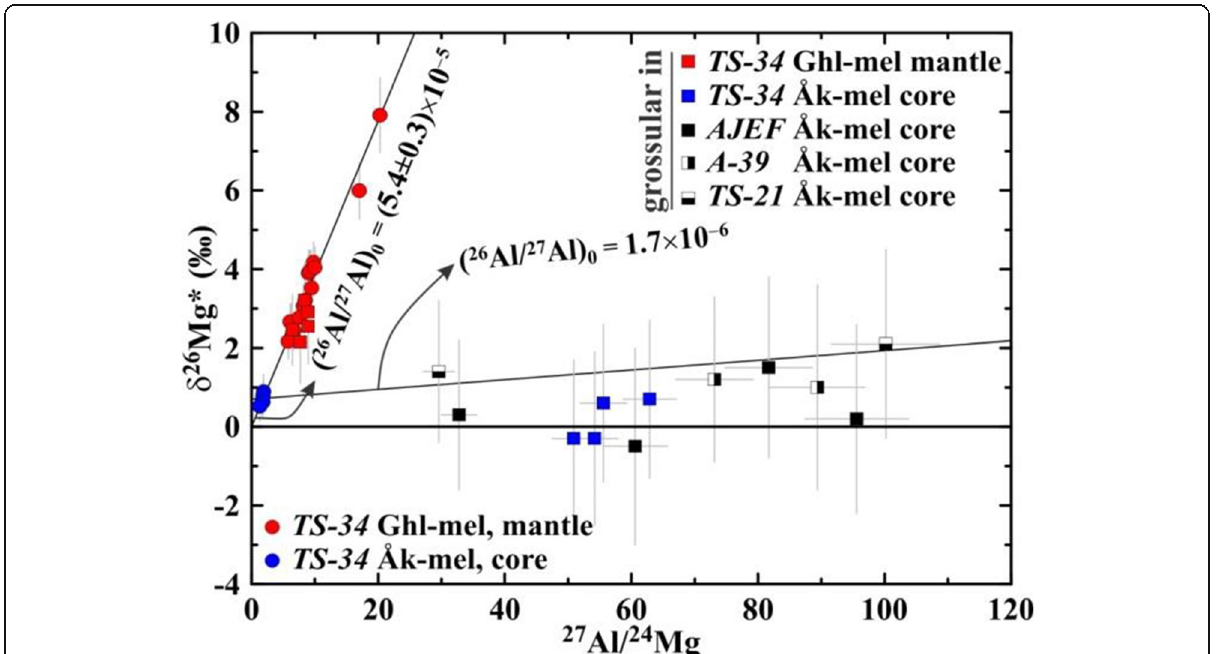
Fig. 14 Aluminum-magnesium isotope diagram of primary melilite in TS-34 (B1) and secondary grossular in TS-34 , AJEF (B1), A-39 (B2), and TS-21 (B2). All melilite analyses show 26 Mg* corresponding to the initial 26 Al/ 27 Al ratio, ( 26 Al/ 27 Al) 0 , of (5.4±0.3)×10 − 5 , which is indistinguishable from the canonical ( 26 Al/ 27 Al) 0 of 5.25×10 − 5 . Grossular grains in nearly monomineralic veins crosscutting gehlenitic melilite mantle in TS-34 show resolvable 26 Mg* and plot along Al-Mg isochron defined by melilite; both minerals have similar 27 Al/ 24 Mg ratios. Coarse grossular grains replacing åkermanitic melilite and associating with monticellite, ±wollastonite, ±Al-diopside, and ±forsterite show no resolvable 26 Mg*; Al-Mg isochron with ( 26 Al/ 27 Al) 0 of 1.7×10 − 6 is shown for reference. We infer that replacement of melilite by grossular took place after nearly complete decay of 26 Al; 26 Mg* in the TS-34 grossular replacing gehlenitic melilite was inherited by the melilite and provide no chronological